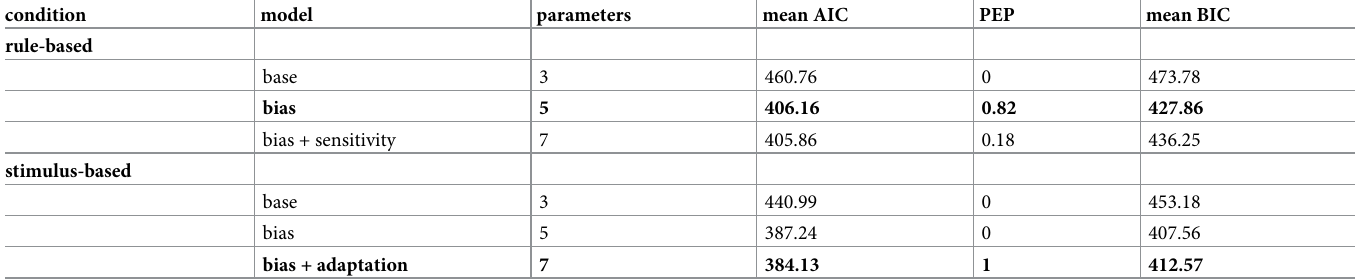
Table 1. Logistic model-fit comparisons. AIC: Akaike information criterion; PEP: protected exceedance probability; BIC: Bayesian information criterion. We selected best-fitting models (bold) on the basis of AIC and PEP. condition